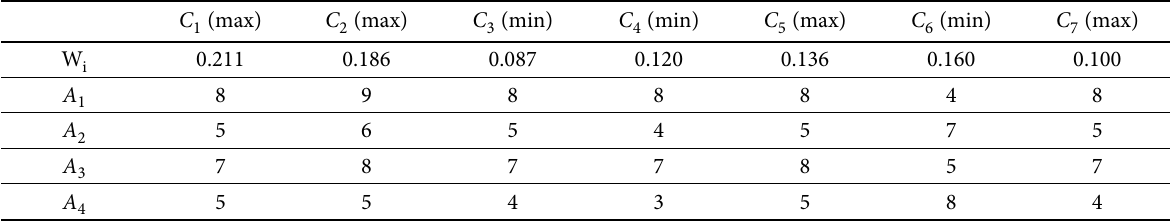
Table 8. Decision matrix of alternatives